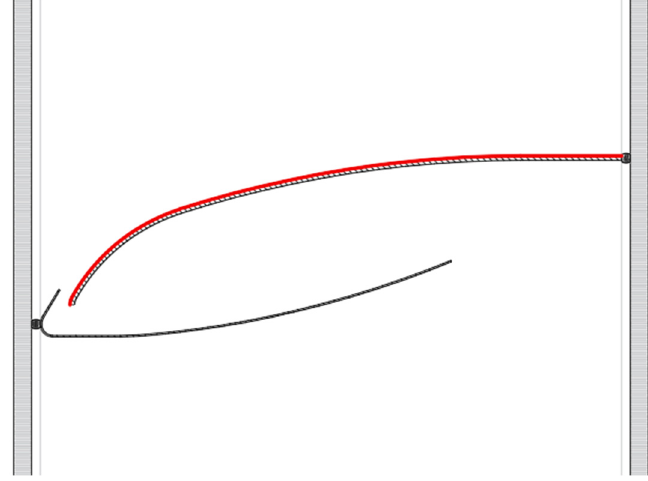
Figure 3. Detail of the model louvres, in red, the photocatalytic coating.